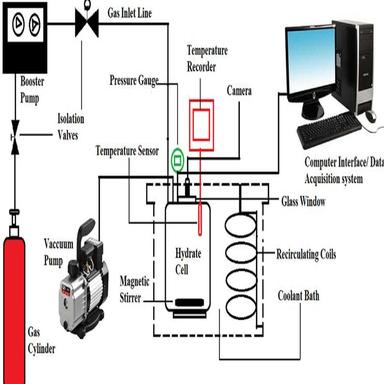
Schematic diagram of the experimental apparatus.